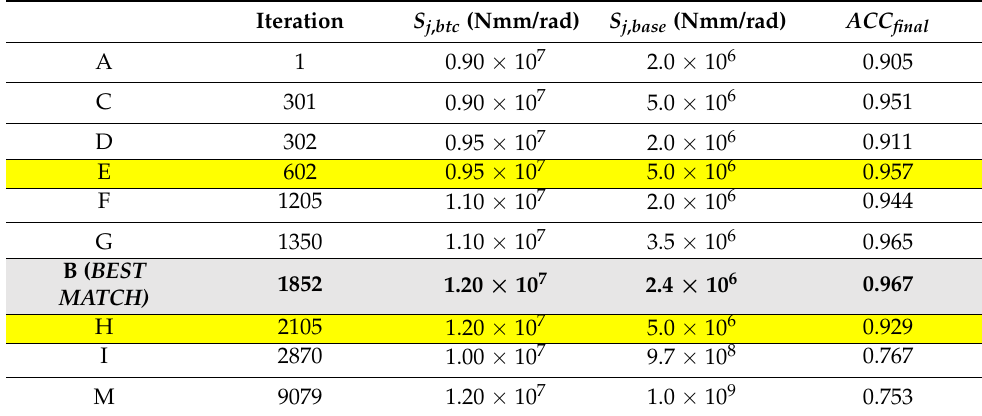
Figure 10. Accuracy: ( a ) total view and ( b ) zoom on the results closest to 1. Table 2. Analysis